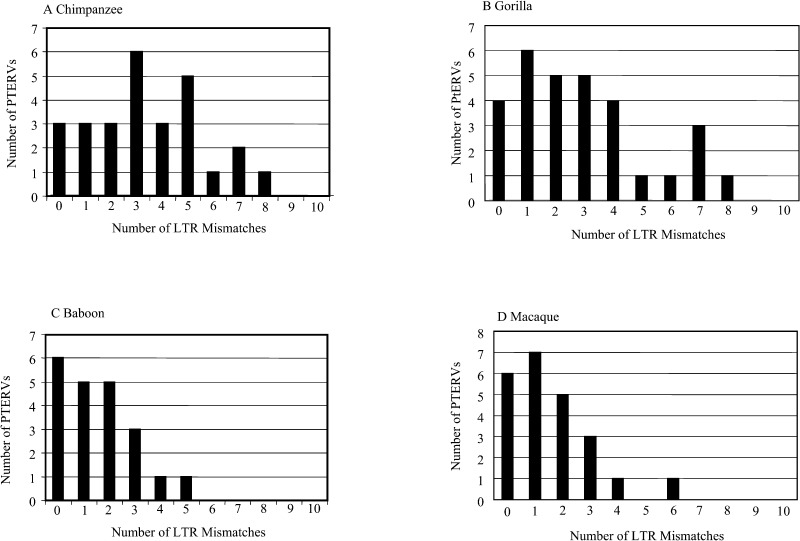
LTR VariationA total of 101 loci that contained full-length PTERV1 elements were examined for the number of mismatches between left and right LTR flanks (295 bp). Different distributions were obtained for Old World monkeys (baboon, mean = 1.6 ± 1.4; macaque, mean = 1.6 ± 1.5) and great ape species (chimpanzee, mean = 3.4 ± 2.2; gorilla, mean = 2.9 ± 2.3).